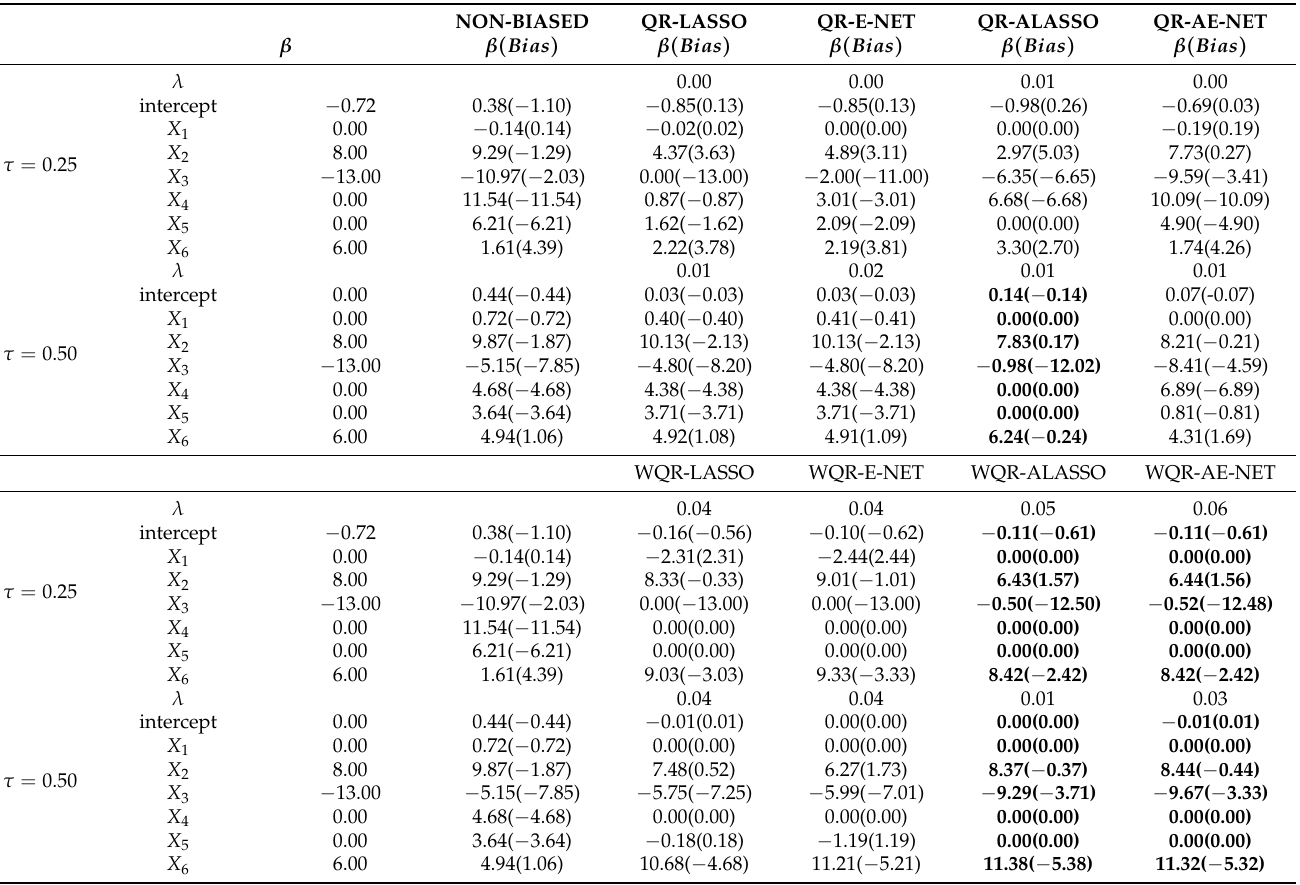
Table 8. Penalized QR parameter estimation results for the Gunst and Mason data set; bold text indicate superior